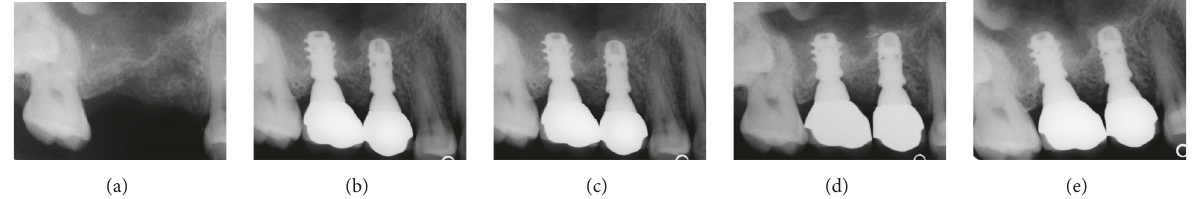
Figure 3: Two implants (#15 and #16) inserted with the transalveolar osteotomy technique: (a) preoperative rx; (b) radiographic control at the delivery of final restorations; (c) radiographic control 1 year after implant placement; (d) radiographic control 5 years after implant placement; (e) radiographic control 10 years after implant placement.